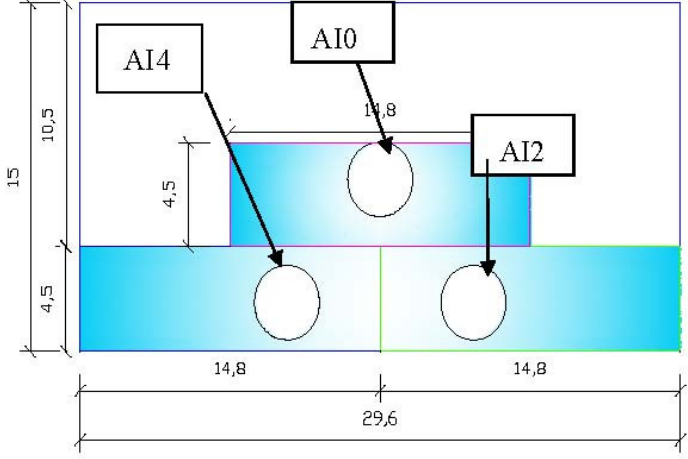
Figure 4. Terminal wall barrier with pressure probes (dimension in cm).